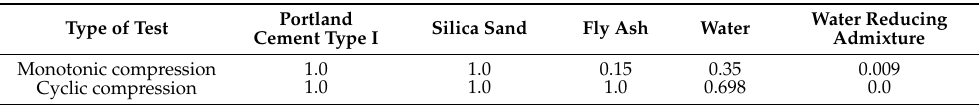
Table 1 summarized the mixture composition of mortar matrix in two cases. Table 1. Mixture composition of mortar matrix with the weight ratio.